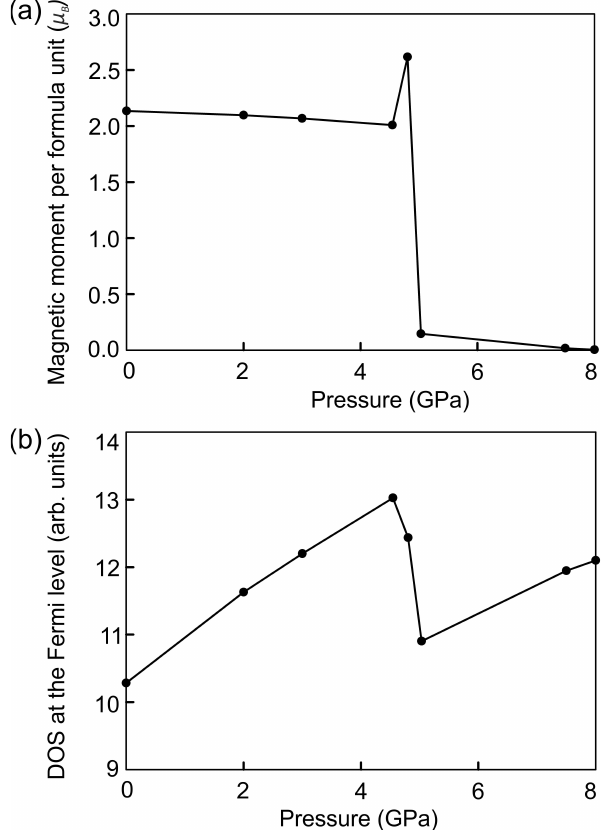
Figure 7. The dependence of the total magnetic moment ( a ) and DOS at the Fermi level ( b ) on external